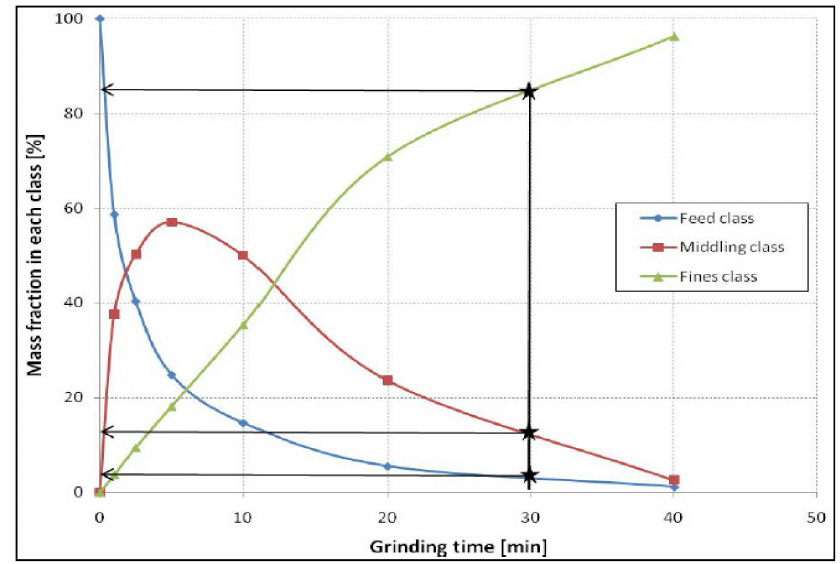
Figure 2. Grinding kinetics as plotted for the three size classes Feed class ( m 1 ), Middling class ( m 2 ) and Fines class ( m 3 ) [9].